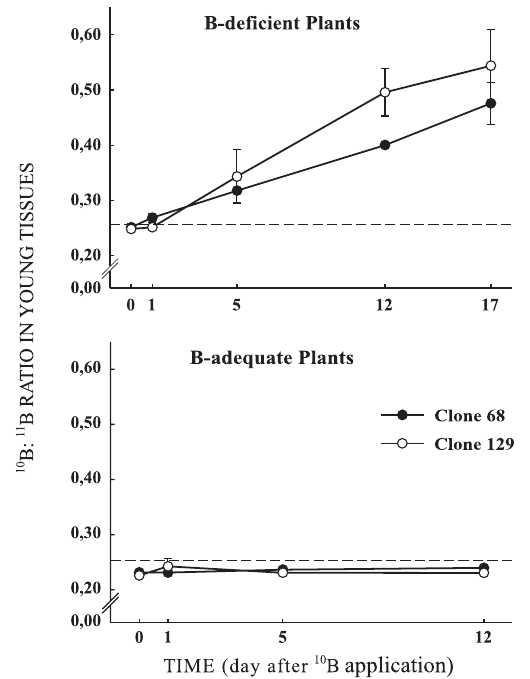
Figure 3. Isotope ratio of 10 B: 11 B in the young tissues over the course of time after application of 10 B to a single mature leaf of B-deficient and adequately supplied plants of two eucalypt clones. The dashed line (----) represents the natural abundance of 10 B: 11 B = 0.247 of the certified standard NIST